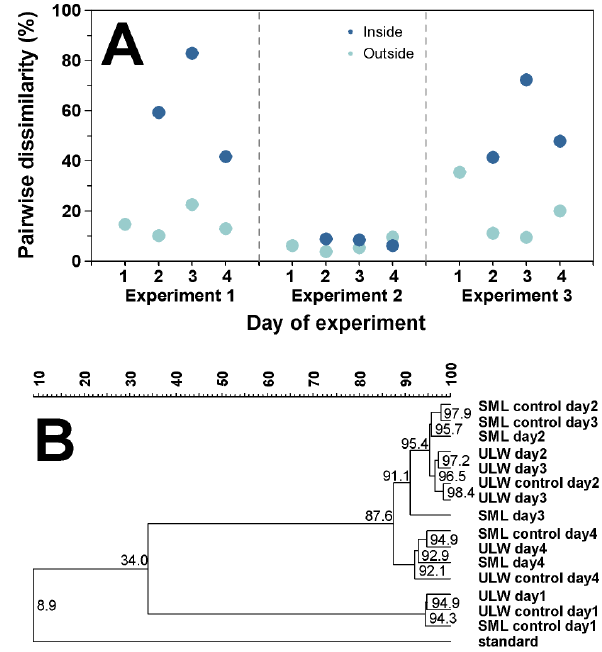
Fig. 4. (A) Pairwise comparison of the total bacterioneuston com- munity inside (coloured circles) and outside (white circles) the mesocosms with respect to bacterioplankton community based on 16S rRNA fingerprints. (B) Cluster analysis of all communi- ties as revealed by their single-strand conformation polymorphism (SSCP) band patterns over the course of four days during the sec- ond experiment. The day of the experiment as well as the ori- gin of the samples are indicated (SML=sea-surface microlayer, ULW=underlying water, control=outside